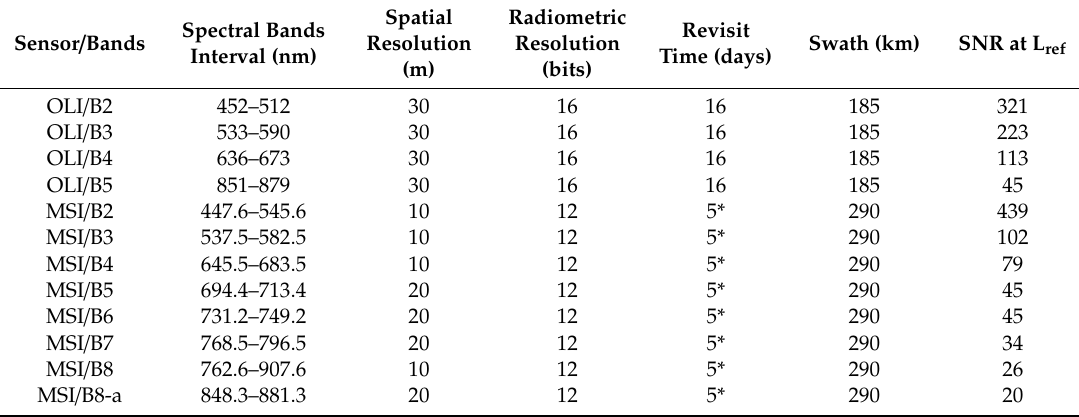
Table 1. The spectral bands; spectral, spatial, radiometric, and temporal resolutions; swath; and Signal-to-Noise Ratio (SNR) for each OLI and MSI bands. * When both Sentinel-2A and Sentinel-2B are